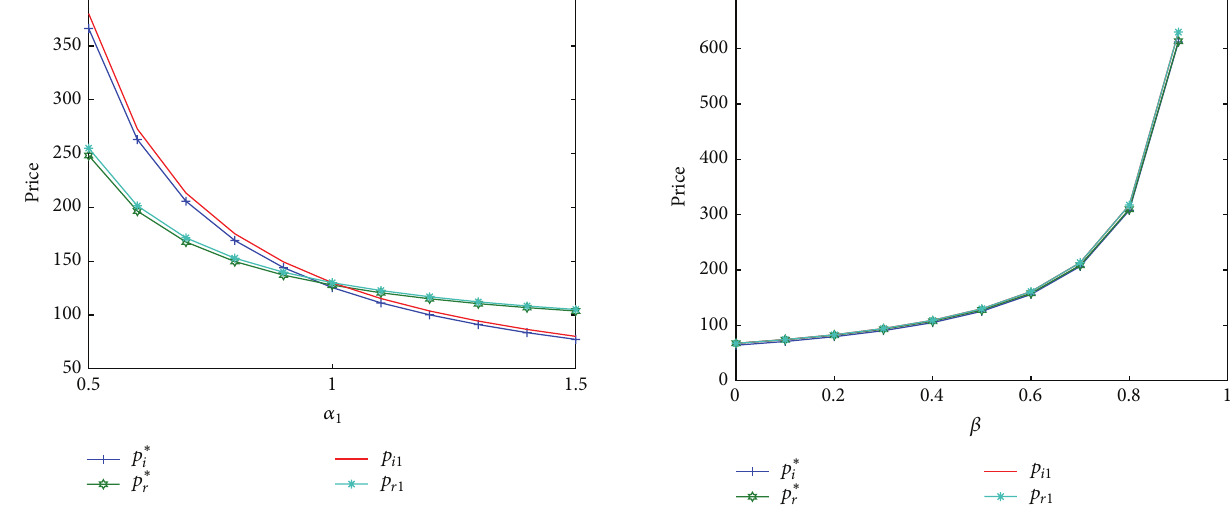
Figure 7: Impact of 𝛽 on pricings under demand certainty and uncertainty.